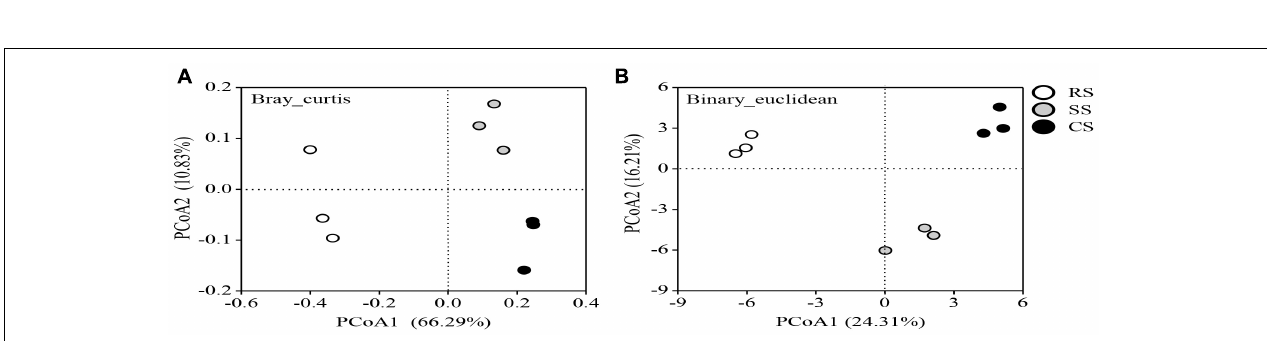
FIGURE 4 | Principal coordinate analysis (PCoA) plot based on the OTUs of Bray (A) and Binary (B) for three soybean cropping systems. RS, SS, and CS represented soybean rotation with a 3-year cycle of wheat, maize and soybean, short-term continuous soybean cropping with 1-year wheat and 2-year soybean, and long-term continuous soybean cropping,